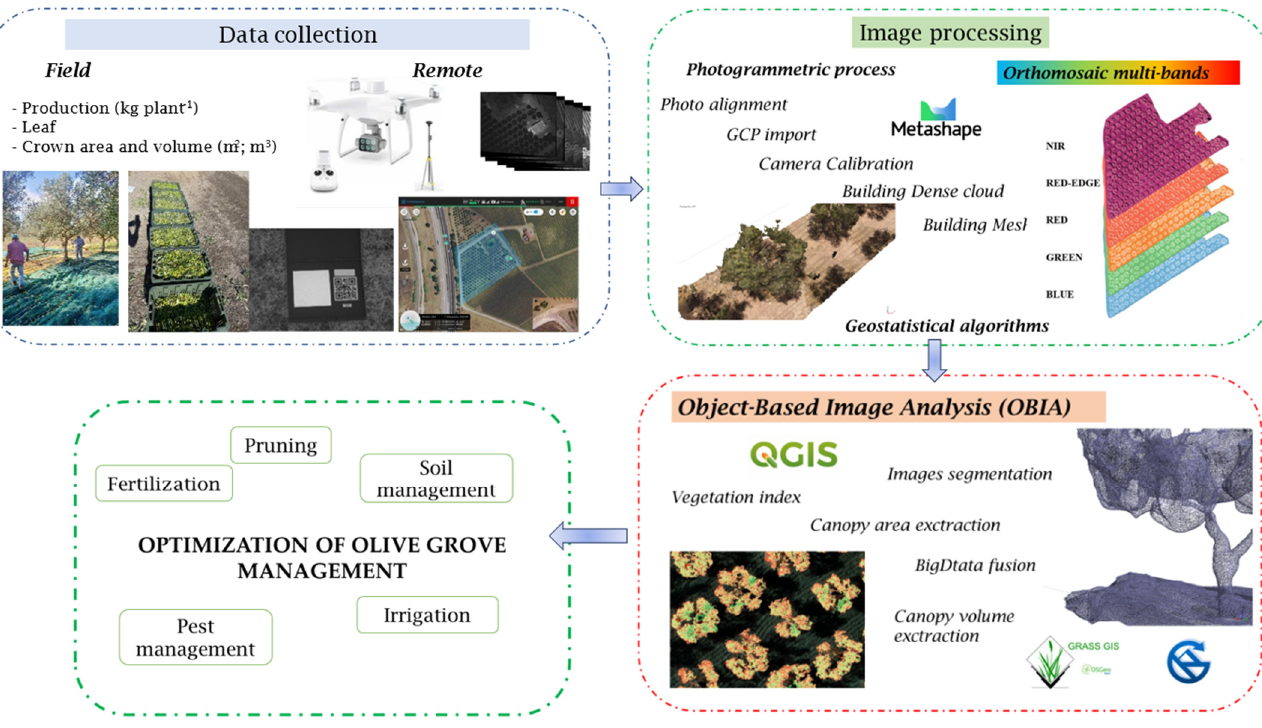
Figure 3. Overall flowchart of the experimental process.